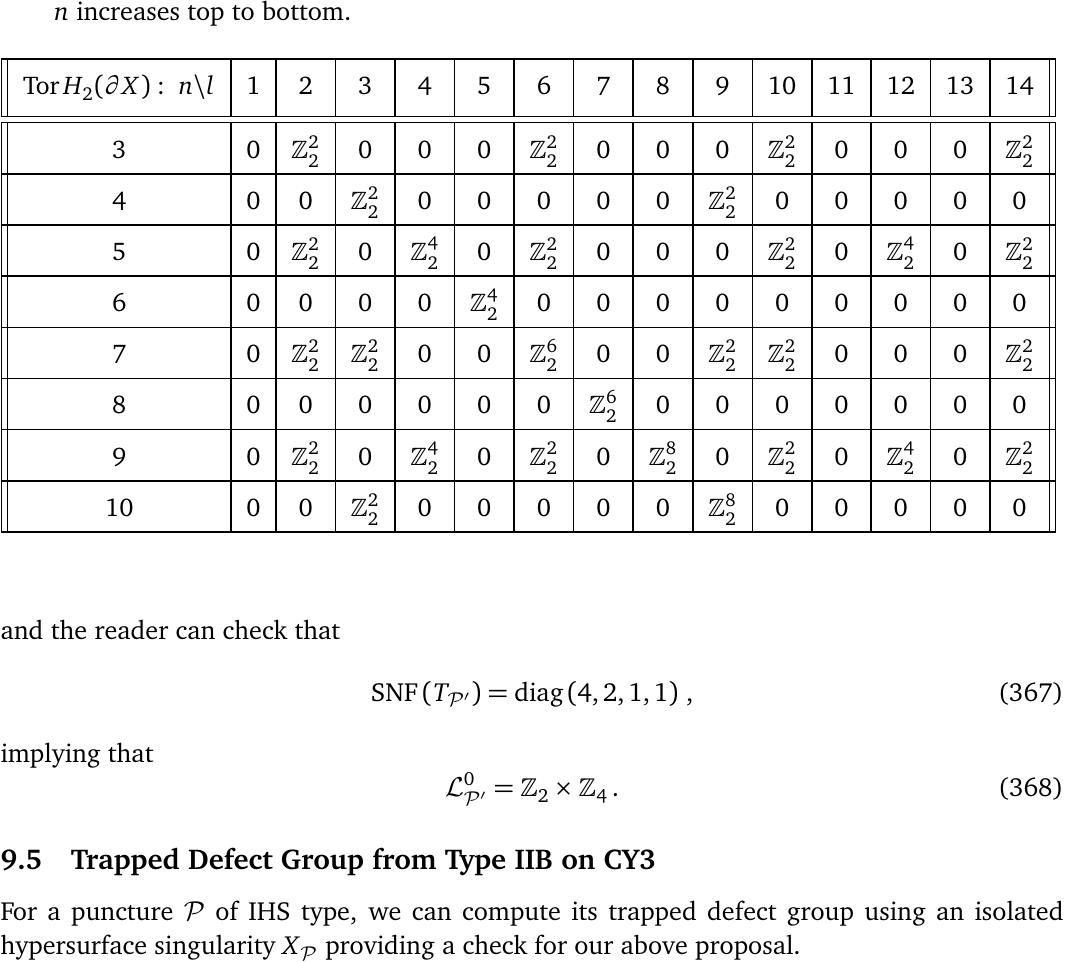
+ x l + 1 + x + x = 0. k increase left to right, x n − 1 x 2 2 3 1 4 3 2